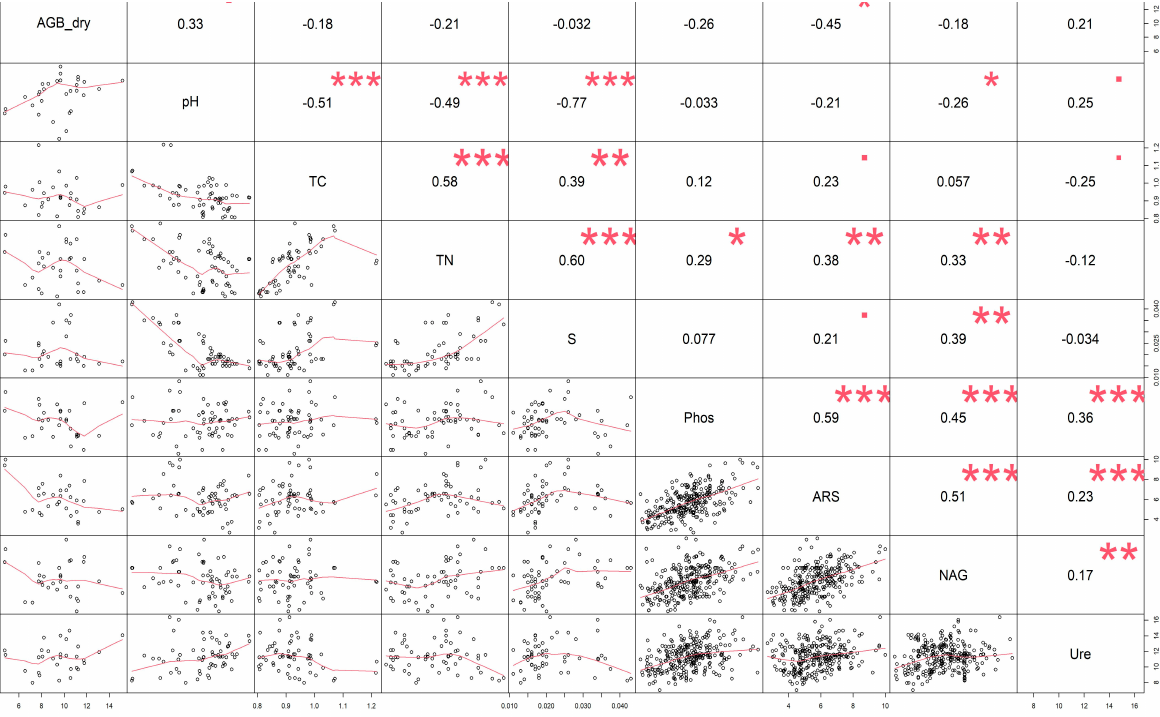
Figure A1. Results of Pearson’s correlation analysis in the pre-cultivation of maize in the pot experiment. The symbols indicate differences between the variables at the following levels of statistical significance: ˙ p ≤ 0.1, * p ≤ 0.05, ** p ≤ 0.01, *** p ≤